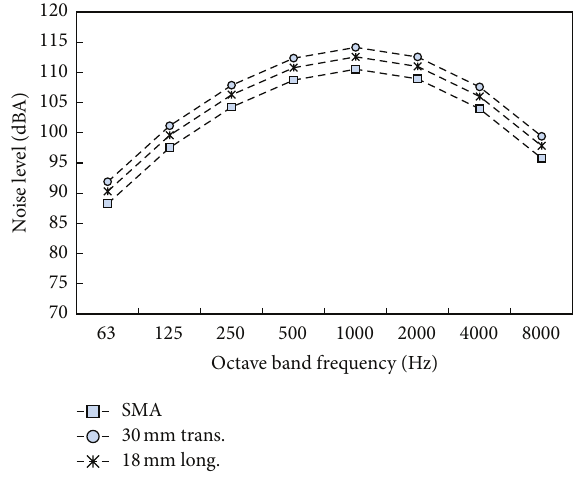
Figure 3: Octave band frequency versus noise